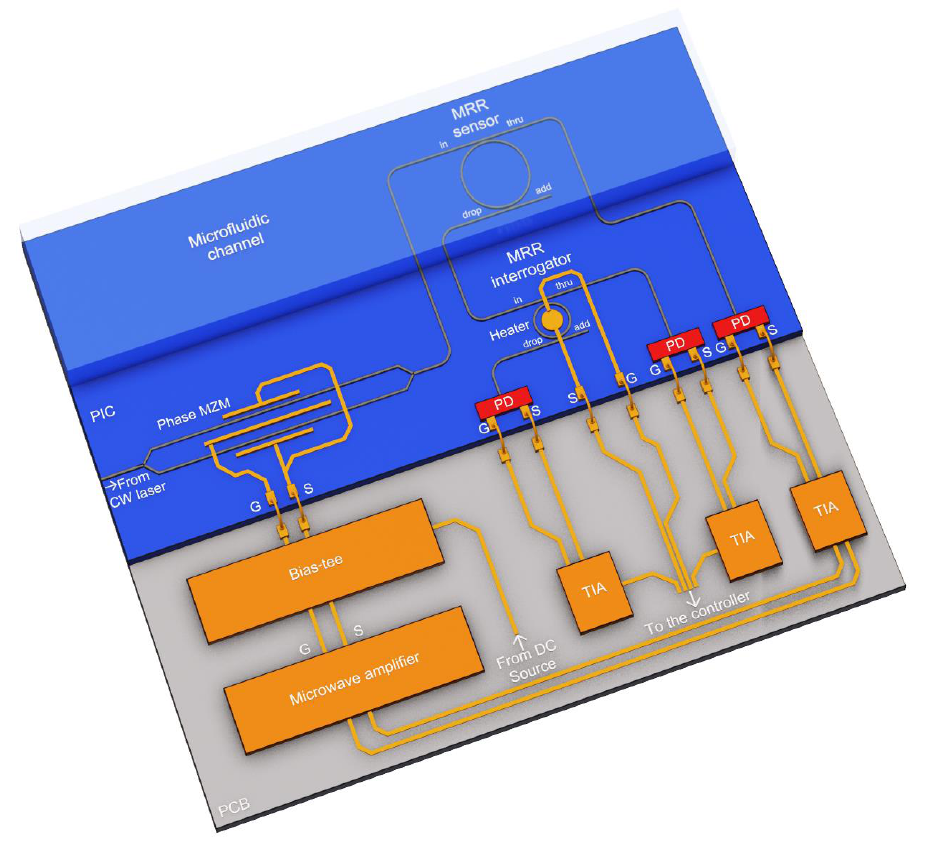
Figure 4. 3D design draft of the proposed integrated sensing system with an OEO (not to